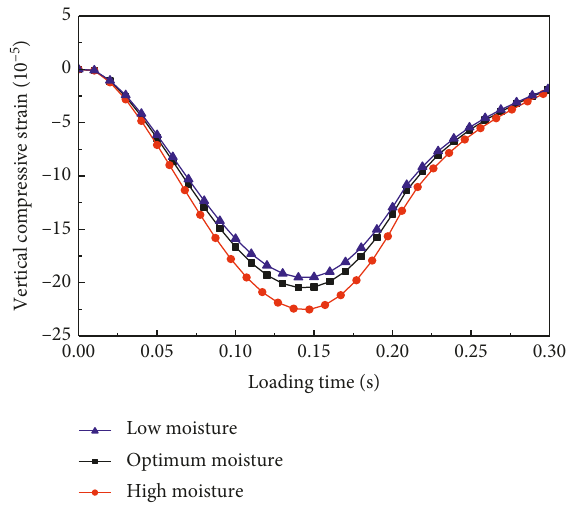
Figure 9: Effect on vertical compressive strain at the top of